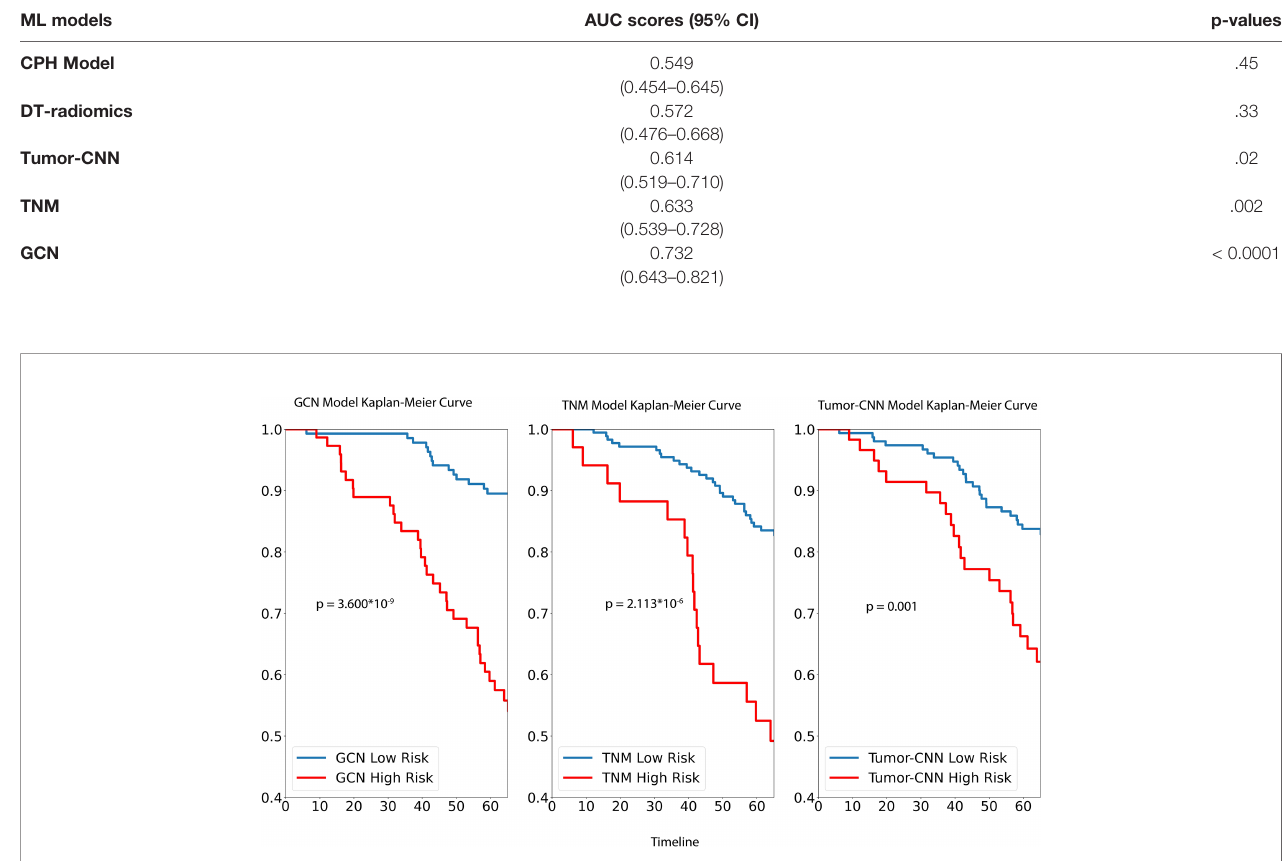
FIGURE 3 | Performance of GCN, TNM and Tumor-CNN models on testing dataset.